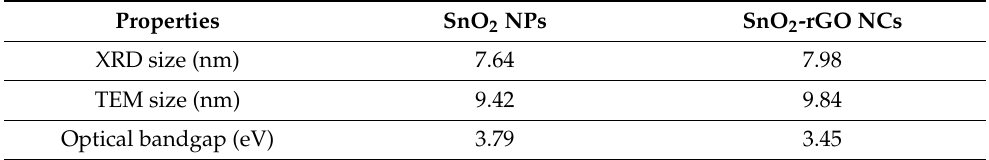
Table 1. Structural and Optical Properties of the SnO 2 NPs and SnO 2 -rGO NCs. Properties